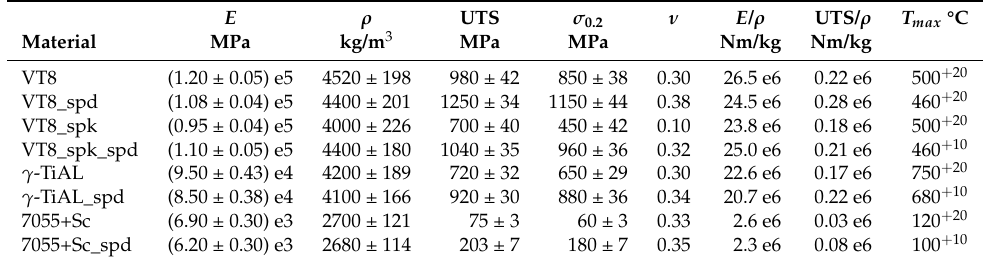
Table 3. Mechanical and physical properties of the alloys considered for compressor